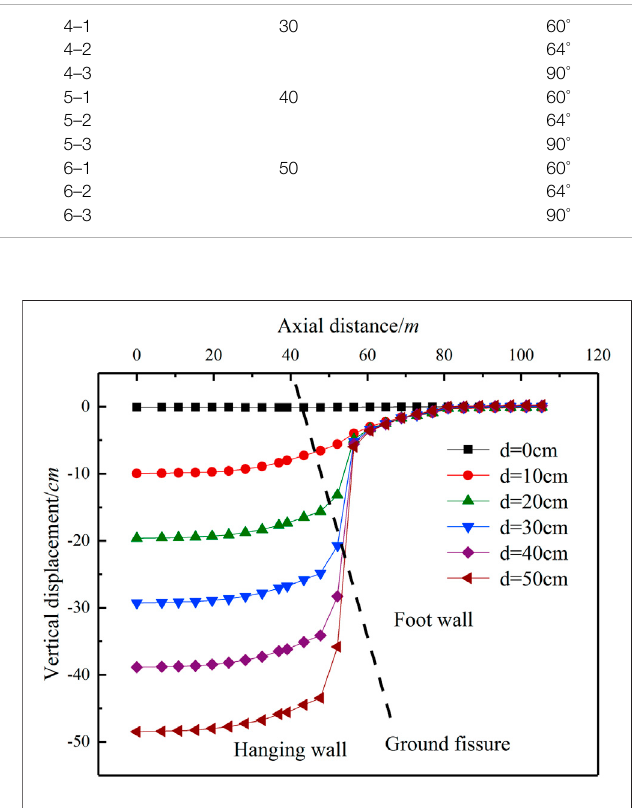
FIGURE 4| Vertical displacement of surface curve ofunderground utility tunnel obliquely crossing the ground fi ssure (inclination 64 ° ).